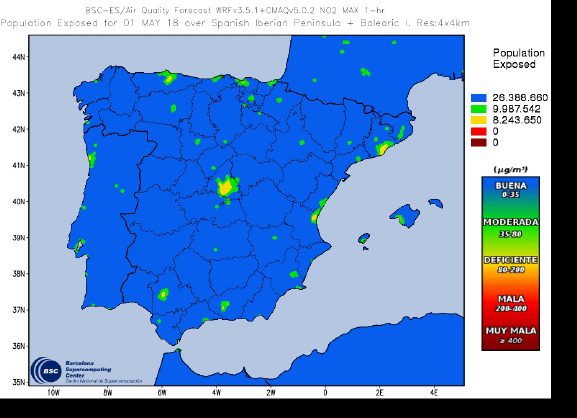
Figure 1. Caliope’s map of NO2 concentration on Iberia Peninsula (4x4km). c (cid:13)